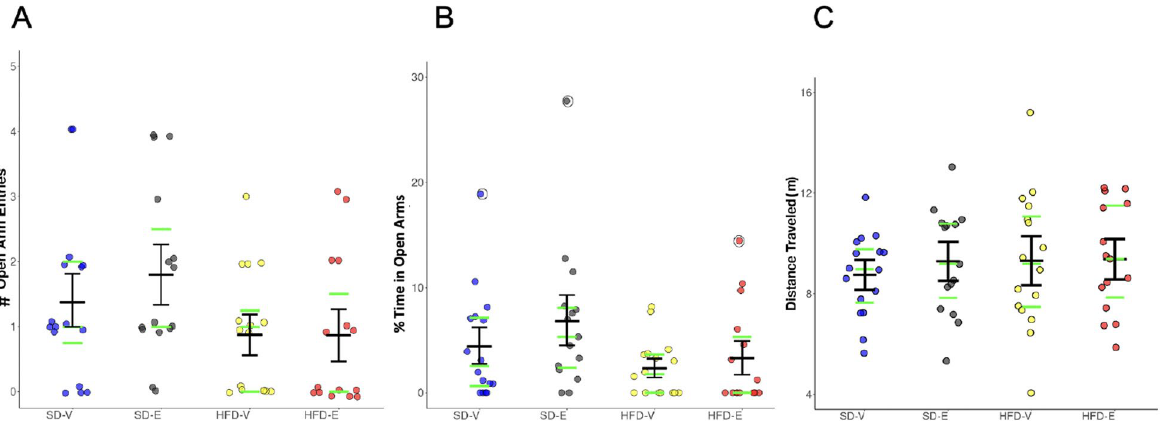
Figure 3. HFD increases anxiety-like behavior in the Elevated Plus Maze test. HFD decreased ( A ) the number of open arm entries, ( B ) time spent in the open arms (n = 15–16/group). For ( A ) and ( B ), a main effect of diet was detected (Kruskal–Wallis, p < 0.05), although individual groups did not differ from each other. ( C ) Total distance traveled. Black lines show mean (middle line) and 83% CI (whiskers). Green lines show median (middle line) and the 1st (lower line) and the 3rd quartile (upper line). Data points greater than 1.5 times the interquartile range are shown within open